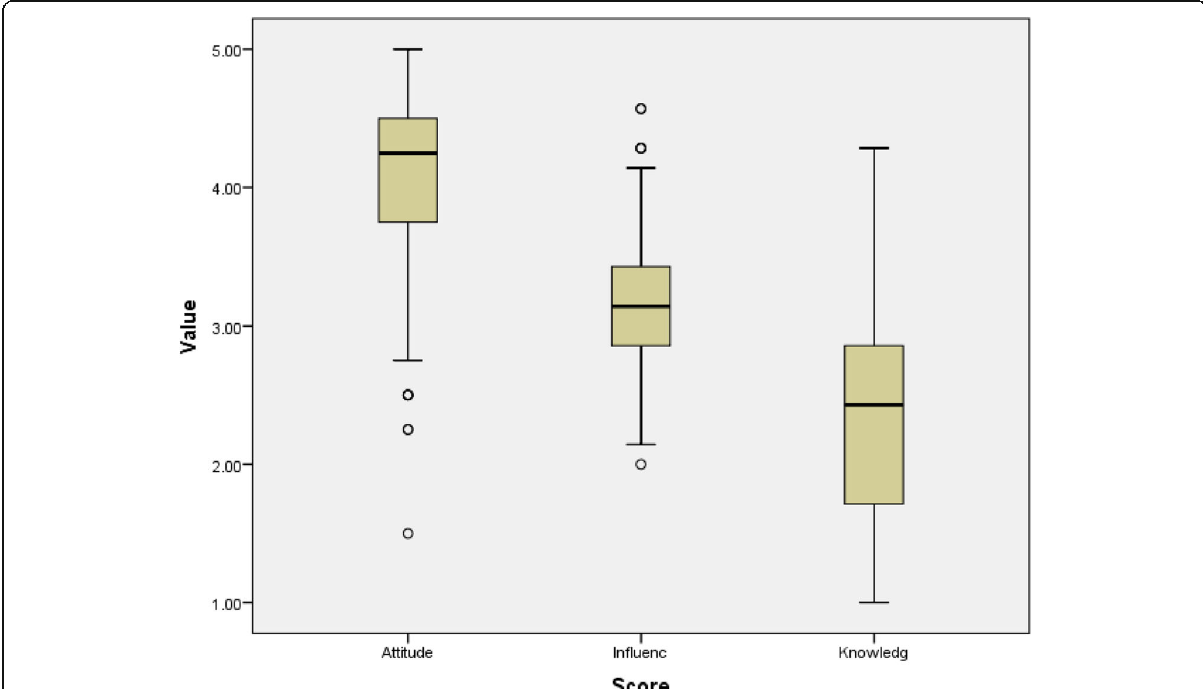
Fig. 1 Distribution of the calculated score among participated physician. The text below each box plot indicates calculated score name. Numbers of included participants in each score was 187 physicians. Calculated attitude score was relatively higher than influence, then knowledge score (median scores were 4.25, 3.1, and 2.5